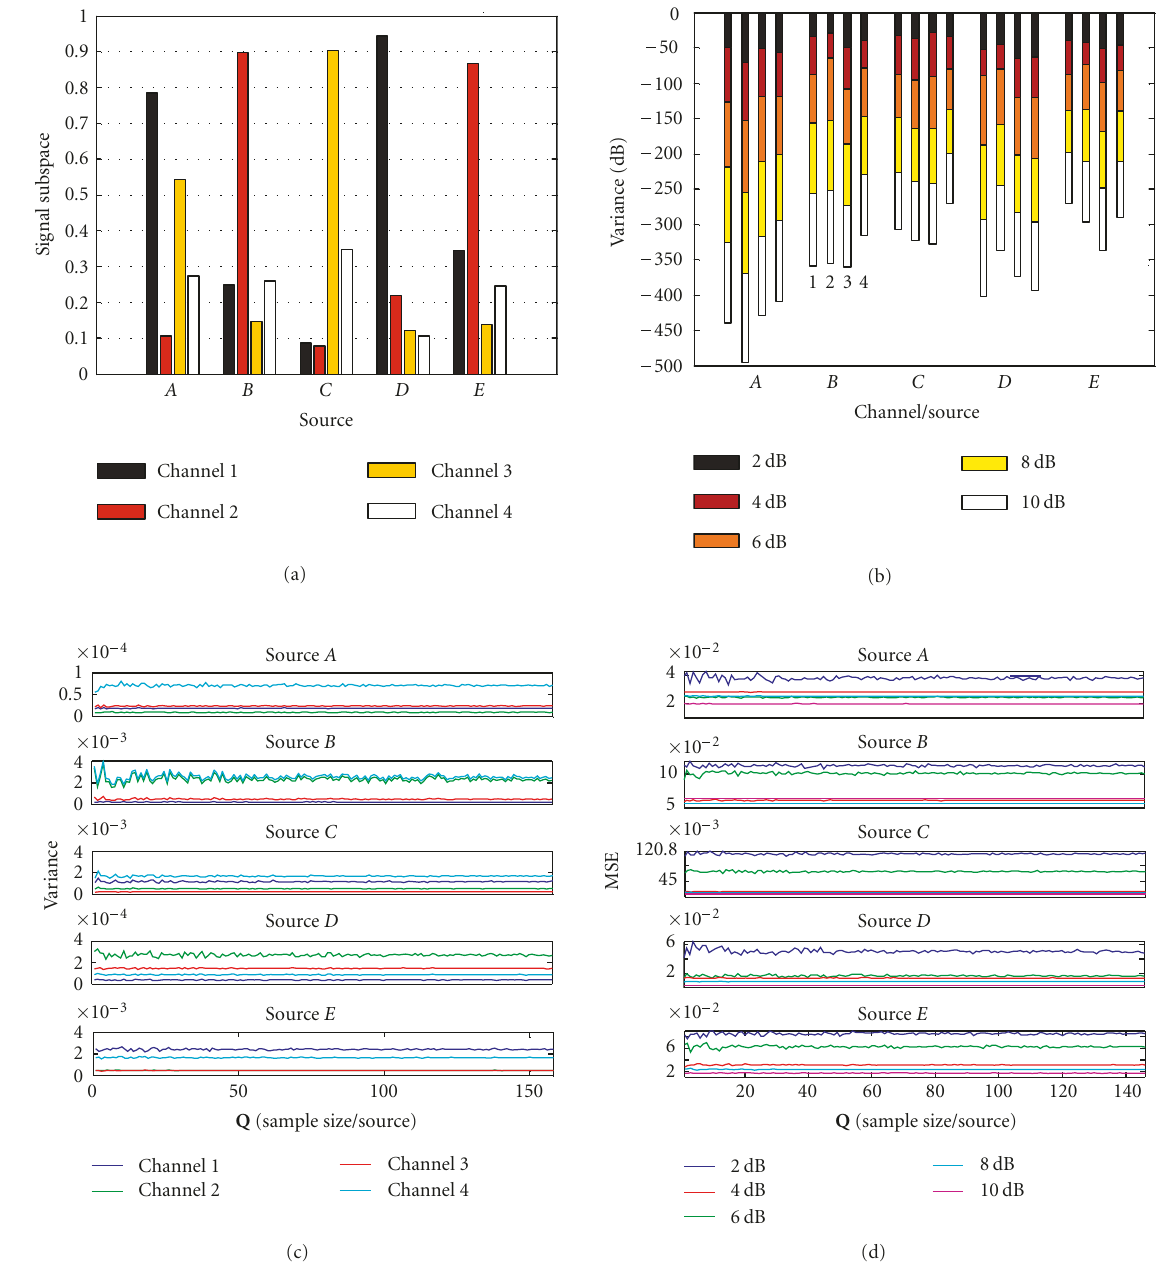
Figure 12: (a) Average estimates of u l p for the neural sources in Figure 11 (SNR = 4dB). (b) Variance of the estimates of u l p versus SNR. (c) Variance of the estimates of u l p versus sample size (of spikes) for each source, for each channel (SNR = 2dB). (d) MSE between the true u l p and the estimated u l p versus sample size versus